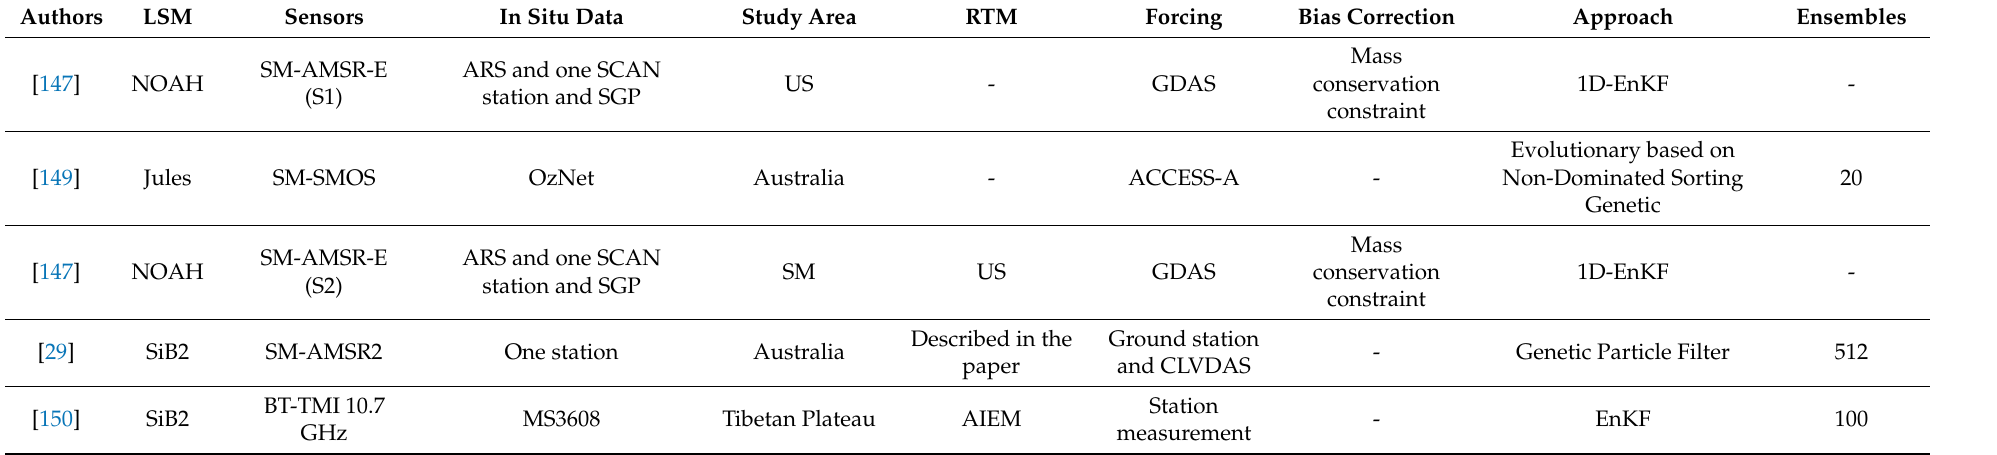
Table 7. RSM RMSE improvements higher than − 0.04 (m3 m-3) for papers reviewed in this study.